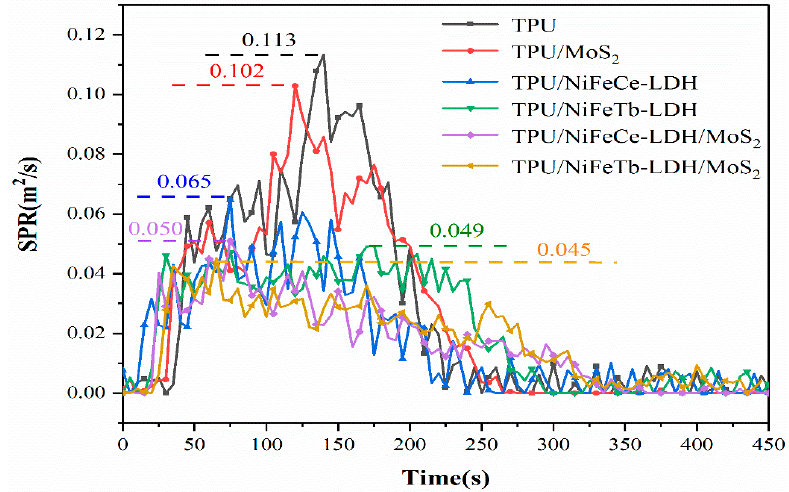
Figure 7. THR curves of pure TPU and TPU composites ( a,b ).